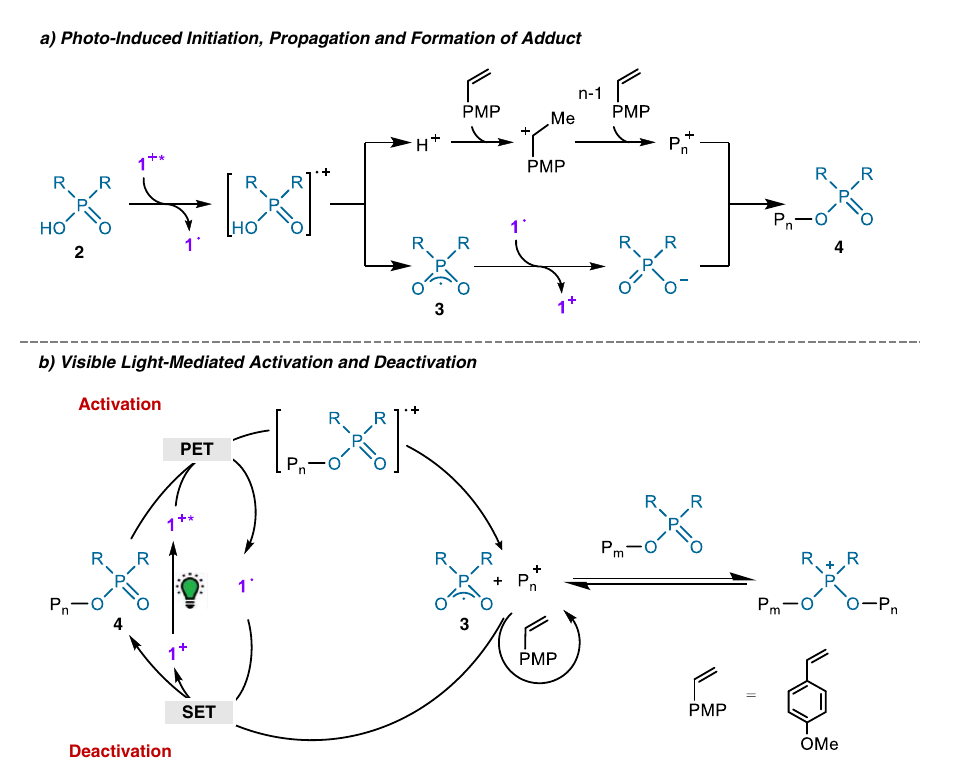
Fig. 6 Proposed mechanism for the photo-controlled living cationic polymerization of p -MOS with OPC 1 and phosphate CTA. a Photo-induced initiation, propagation and formation of adduct. b Visible light-mediated activation and